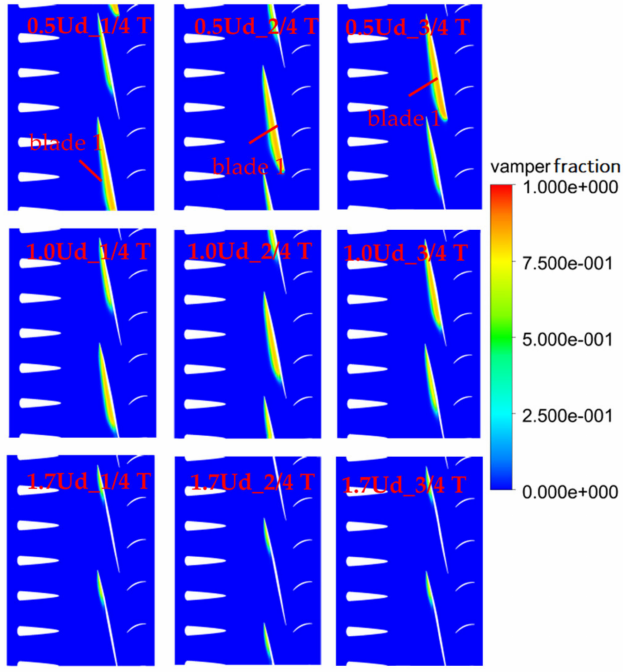
Figure 25. The vapor fraction at the 90% blade